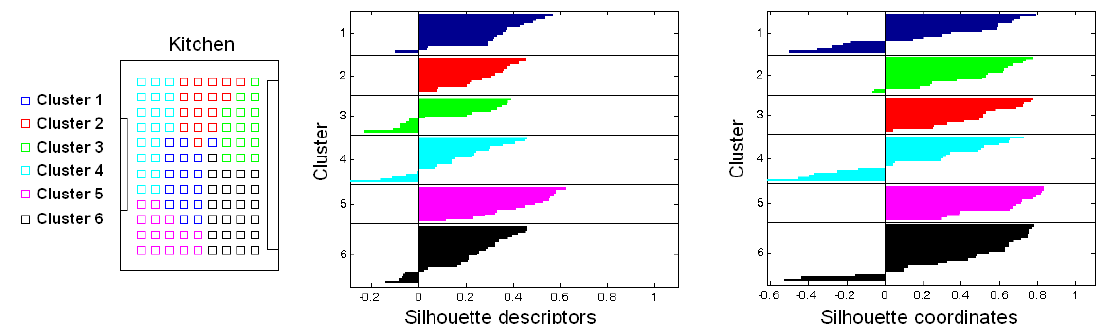
Figure 13. Results of a sample successful clustering process performed with the images of the kitchen room. Bird’s eye view of the capture points, showing with colors their belonging to the resulting clusters, silhouette calculated from the visual descriptors and silhouette calculated from the coordinates of the capture points. Table 4. Results of the intermediate-clustering process. Average silhouette calculated from the descriptors s descr (and standard deviation σ descr ) and from the coordinates of the capture points s coor (and standard deviation σ coor